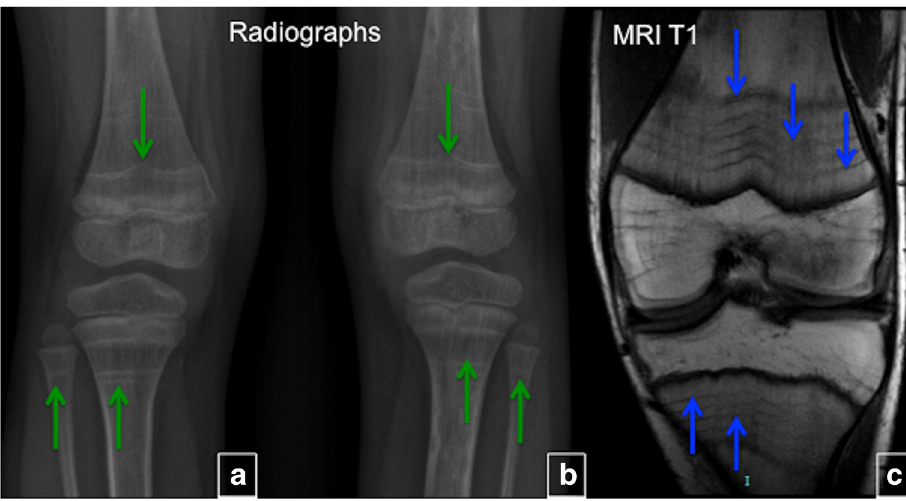
Fig. 14 Bisphosphonate-induced lines. Administration of bisphosphonates results in the development of the parallel sclerotic metaphysial bands, which can be seen on radiographs ( green arrows ) and T1-weighted MRI ( blue arrows )